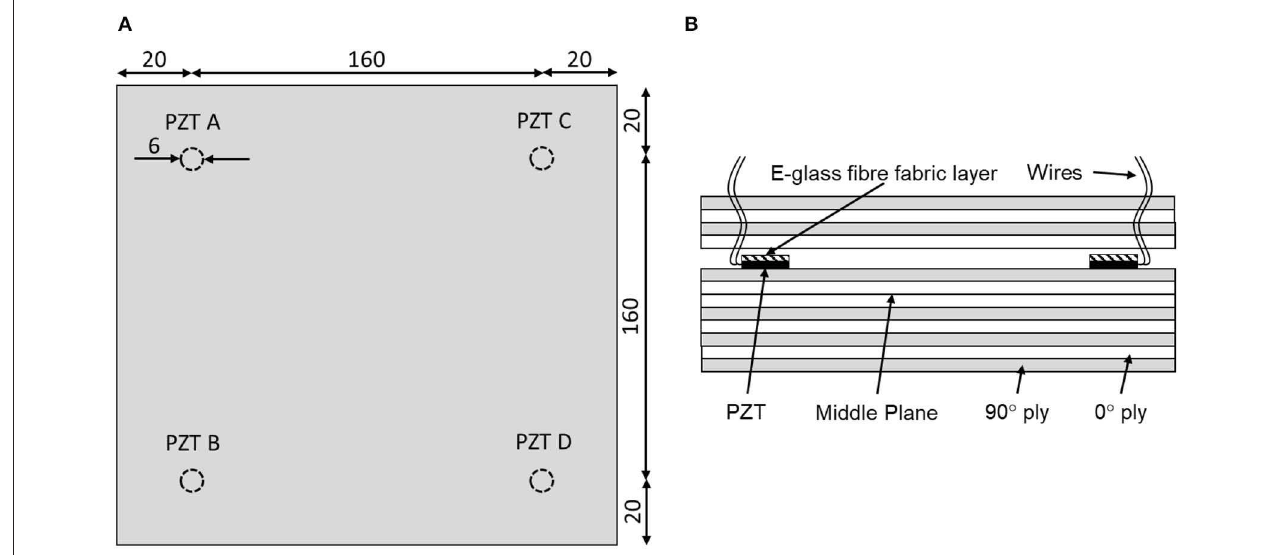
FIGURE 1 | Positions of embedded PZTs in CFRP plate (A) and lay-up of CFRP plate (B) Dimensions in mm. Not to